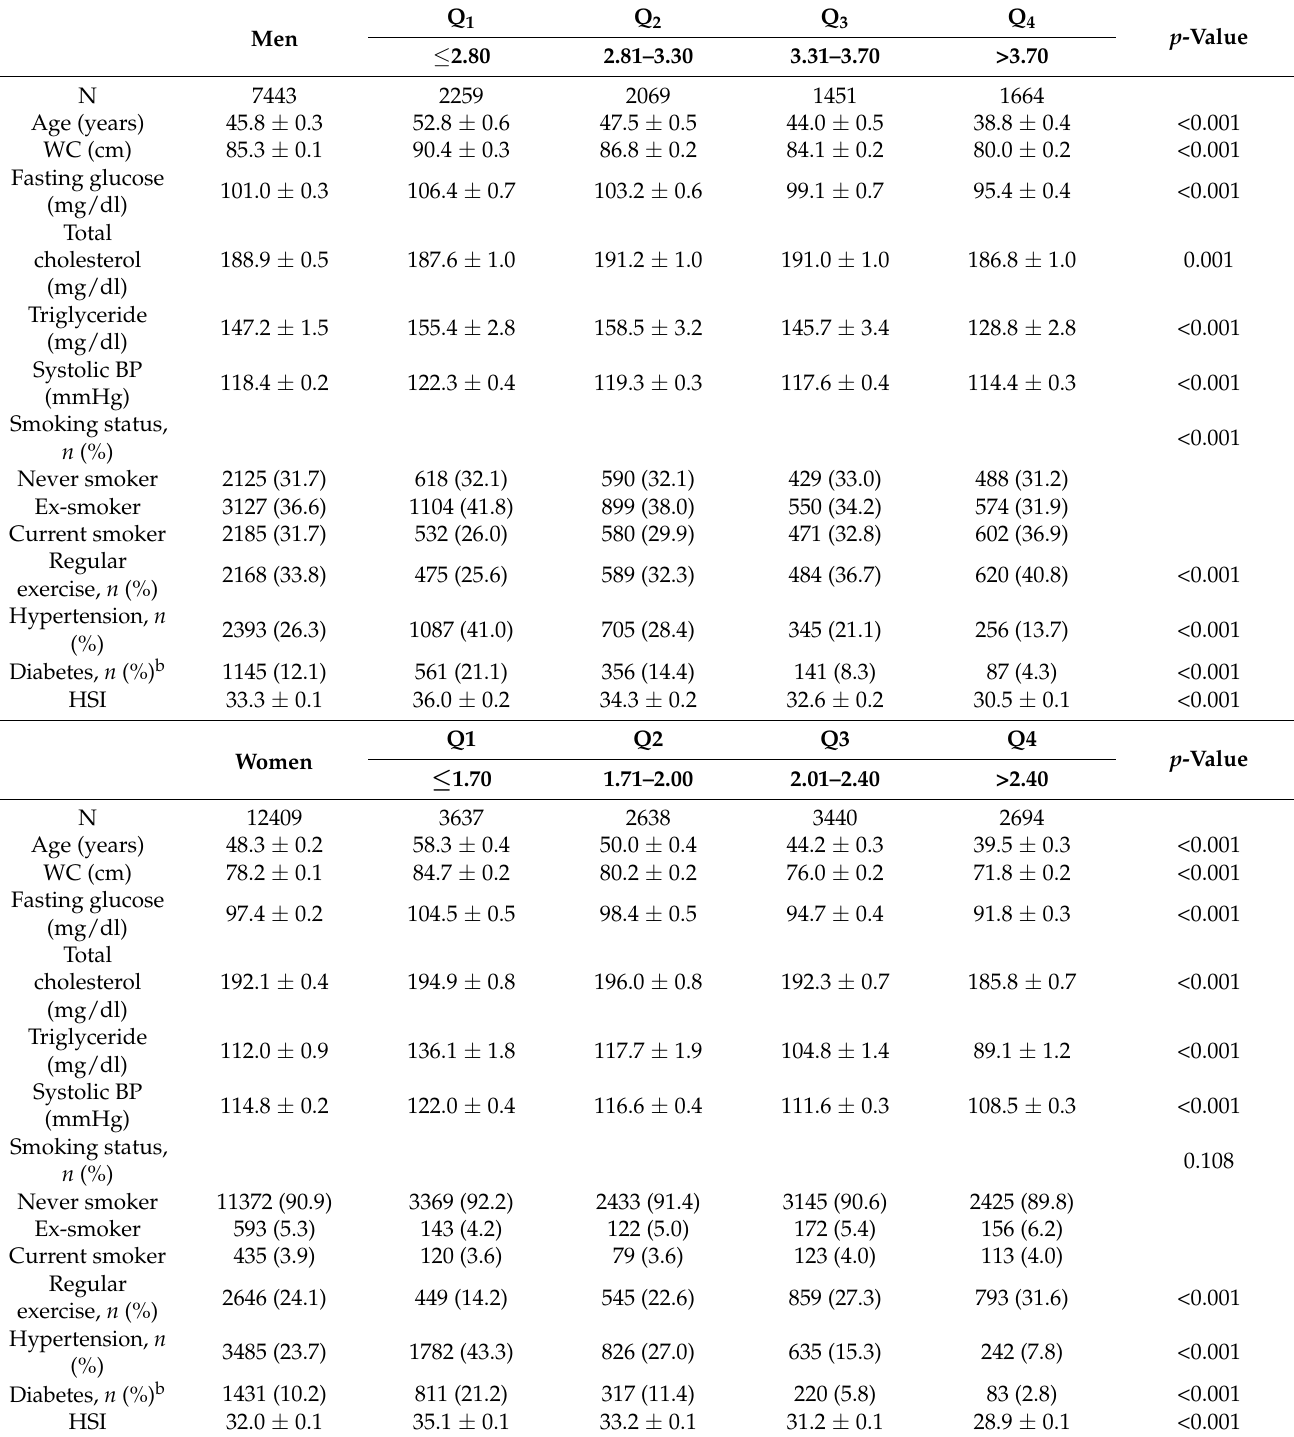
Table 1. Baseline characteristics according to RGS